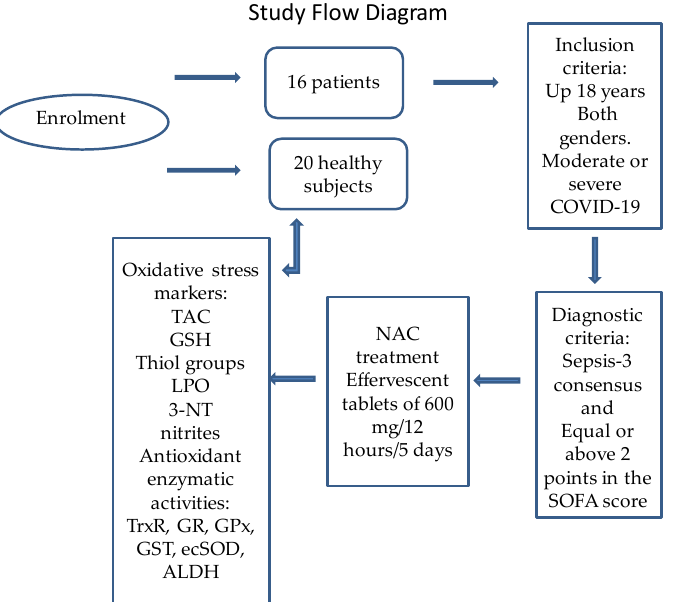
Figure 4. Study flow diagram. Abbreviations: GPx = glutathione peroxidase, GR = glutathione re- ductase, GSH = glutathione, GST = glutathione-S-transferase, LPO = lipoperoxidation, NAC = N- acetylcysteine, SOD = superoxide dismutase, TAC total antioxidant capacity, TrxR = thioredoxin reductase, 3-NT = nitrotyrosine, ALDH = aldehyde deshydrogenase activity.